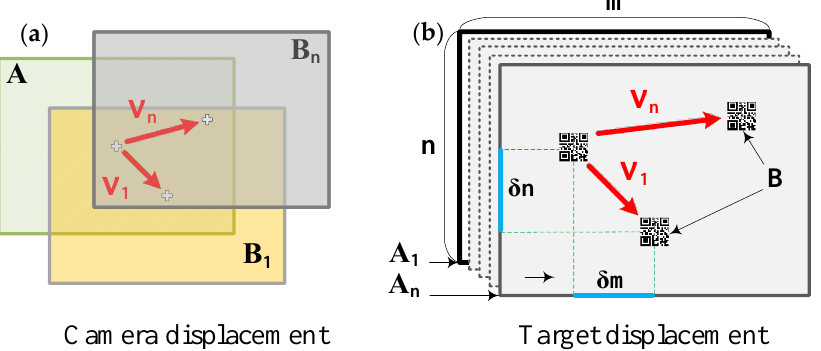
Figure 17. The scheme of the displacement determination ( 𝑉 1 = δ𝑛 12 + δm 12 ; 𝑉 𝑛 = δ𝑛 𝑛2 + δm 𝑛2 ): ( a ) for camera; ( b ) for target.